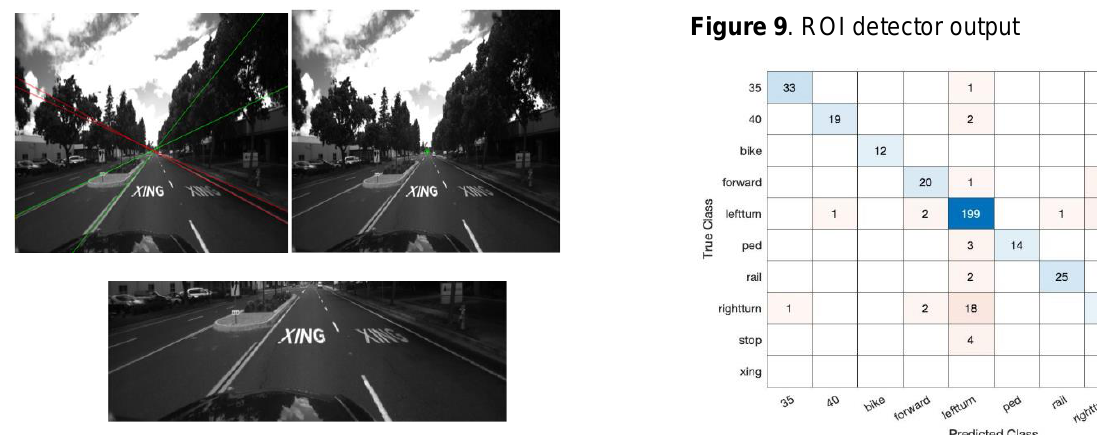
Figure 7. Hough lines (left), intersections (right), cropped image (bottom)